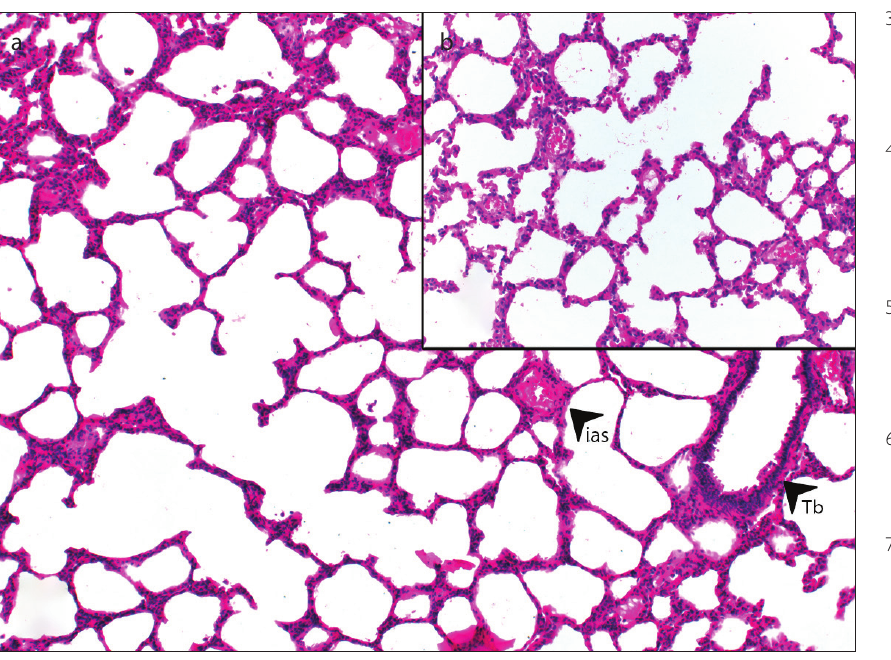
Figure 3. a, b. Appearance after treatment with 100 mg/kg bosentan: (a) ias, interalveolar septum; Tb, terminal bronchiole (H&E, ×100); (b) (H&E,